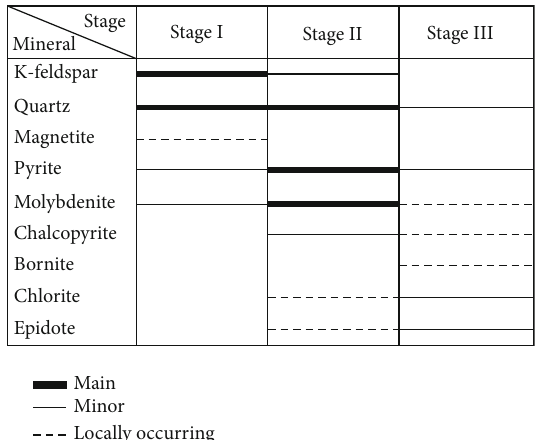
Figure 5: Paragenetic sequence of the Tieling Cu-Mo